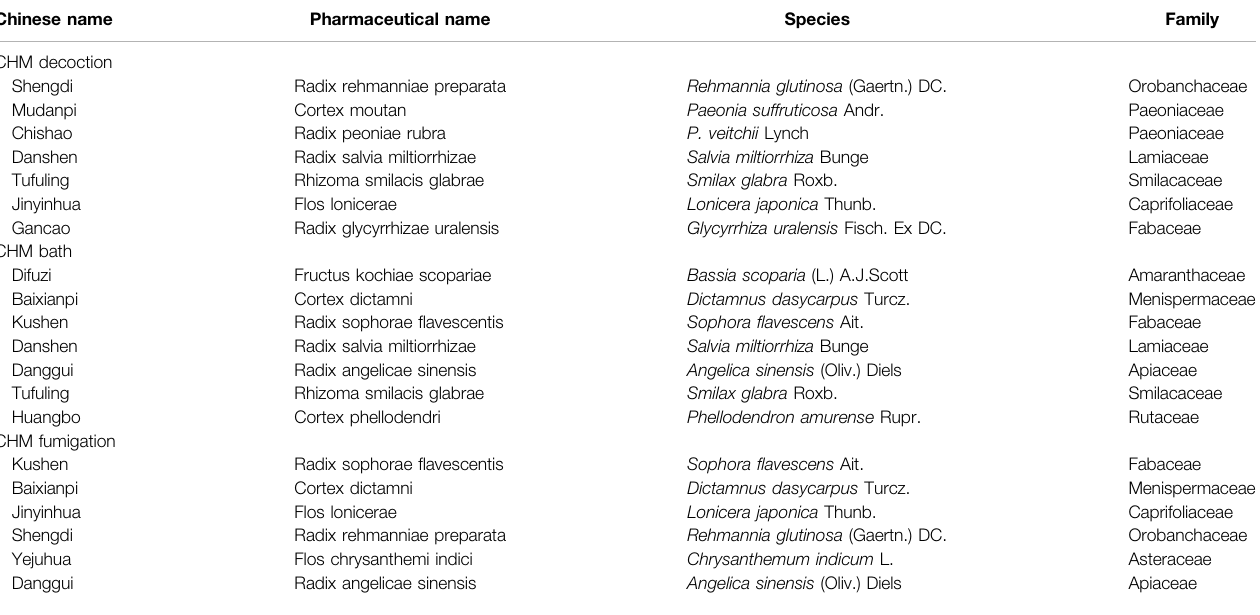
TABLE 2 | Details of highly frequently used herbs for psoriasis in the CHM decoction, bath, and